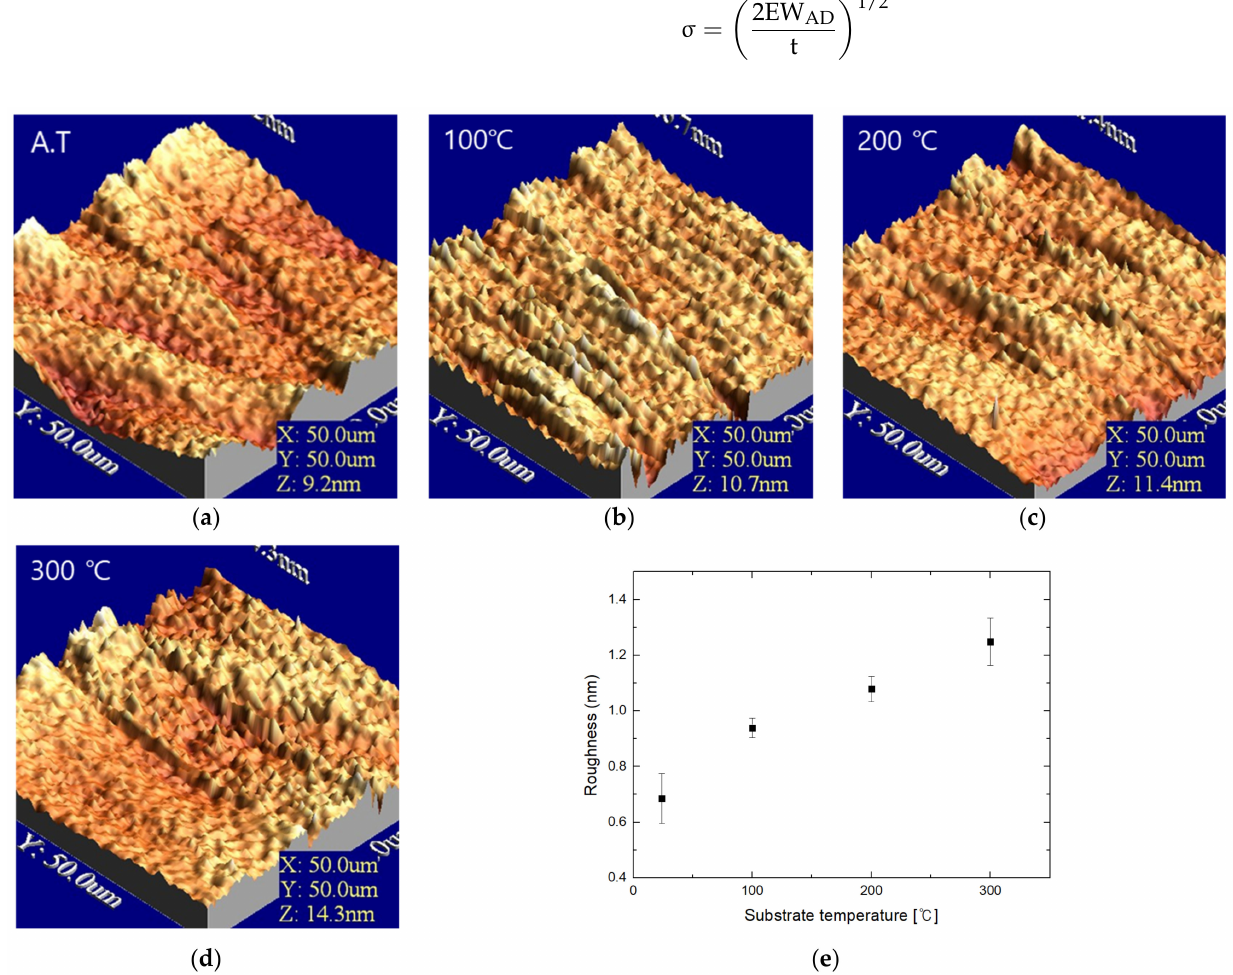
Figure 3. AFM image of thin films with different substrate temperatures: ( a ) ambient temperature (~24 ◦ C); ( b ) 100 ◦ C; ( c ) 200 ◦ C; ( d ) 300 ◦ C; and ( e ) RMS